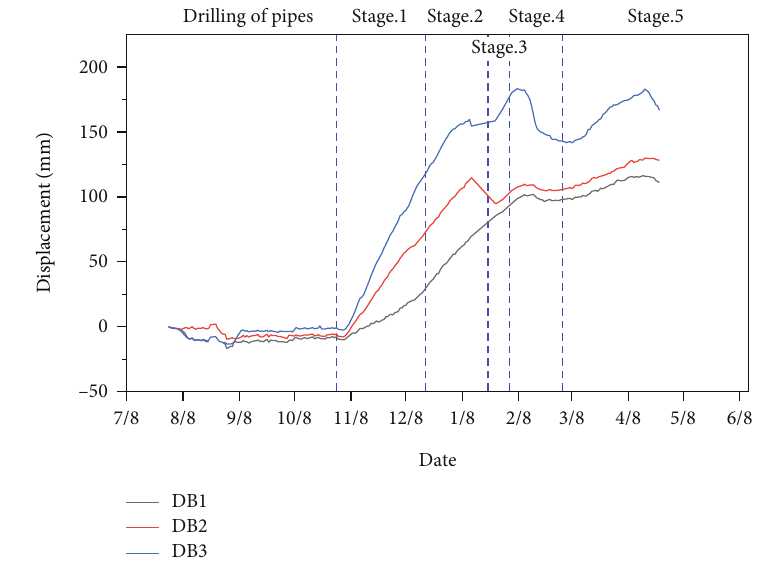
Figure 9: Displacement of ground. Table 2: Parameters for calculation of frozen